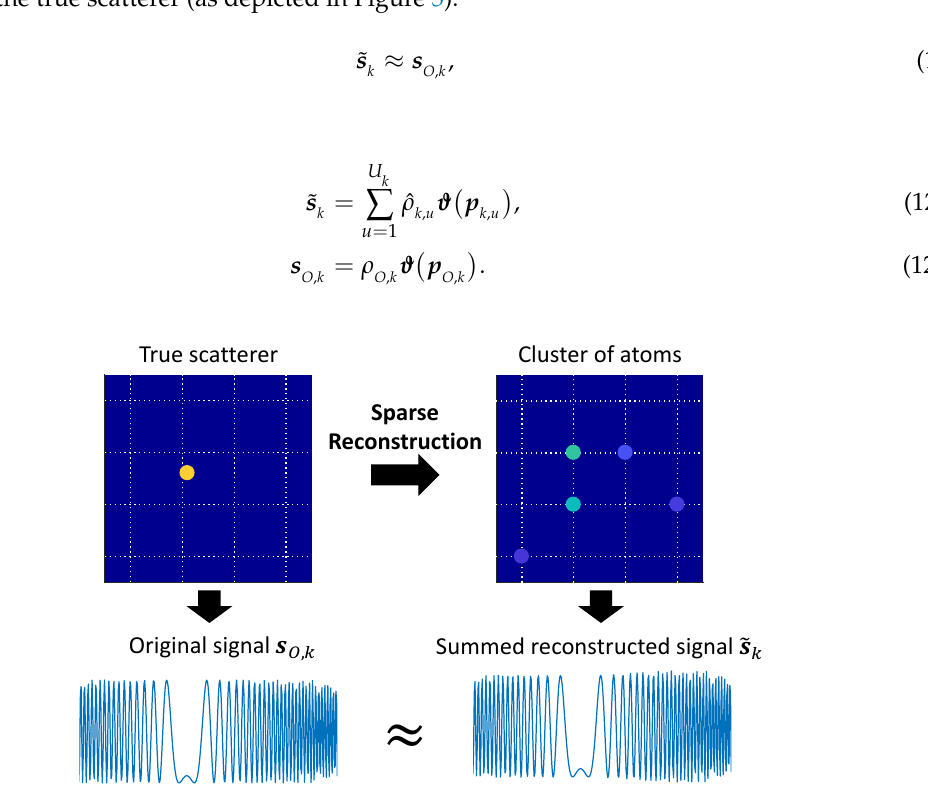
Figure 5. Approximate equivalence between the backscattered signal of a true scatterer and the summed reconstructed signal of the corresponding cluster of